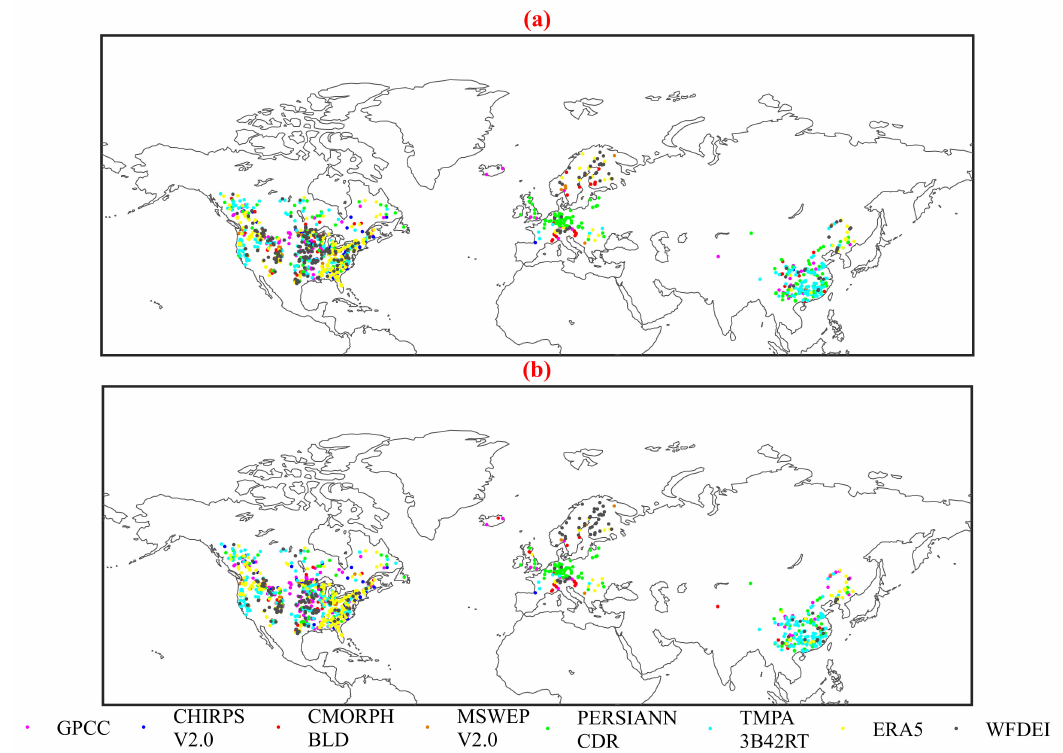
Figure 7. For each catchment, the PPs with the highest improvement by applying ( a ) PPs-specific calibration (step 2) and